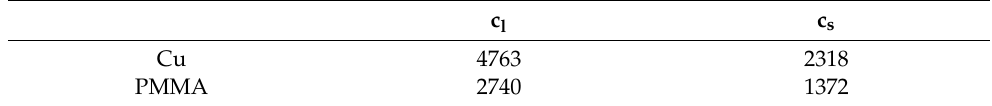
Figure 2. Typical Finite Element Model. Table 1. Finite element simulation parameters.